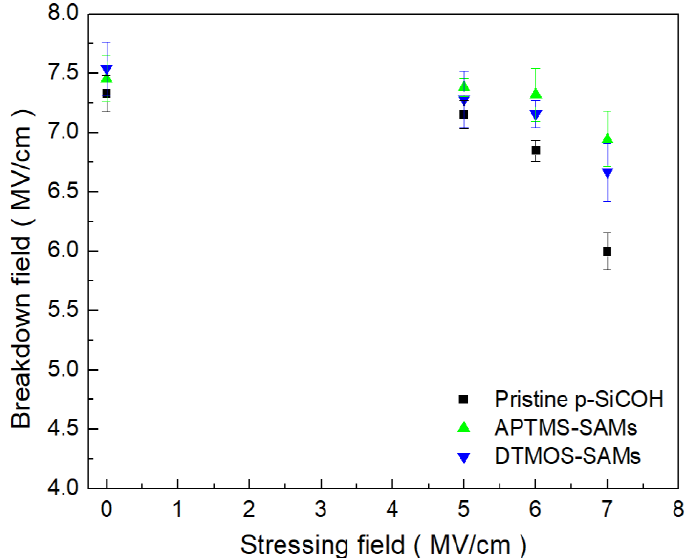
Figure 9. Reduction of breakdown field after electric stress at various fields for pristine, APTMS-SAMs, and DTMOS-SAMs p-SiOCH films.